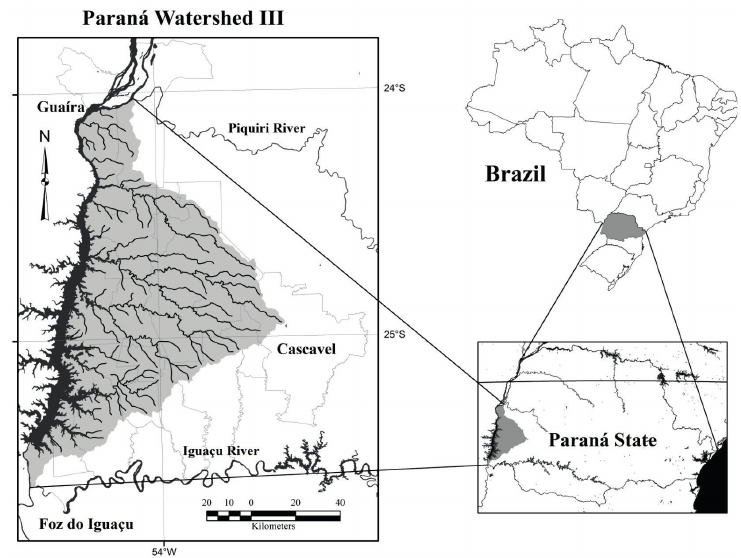
Figure 1 - Study area